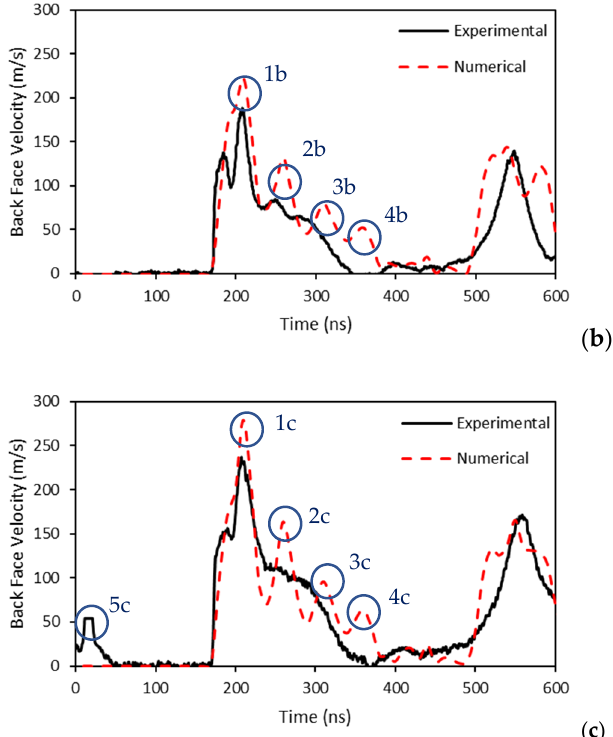
Figure 8. Comparison between the predicted and experimental back face velocity profiles for alu- minum 2024/epoxy substrates for three different laser intensities: ( a ) 2.32 GW/cm 2 , ( b ) 4.96 GW/cm 2 and ( c ) 6.81 GW/cm 2 .